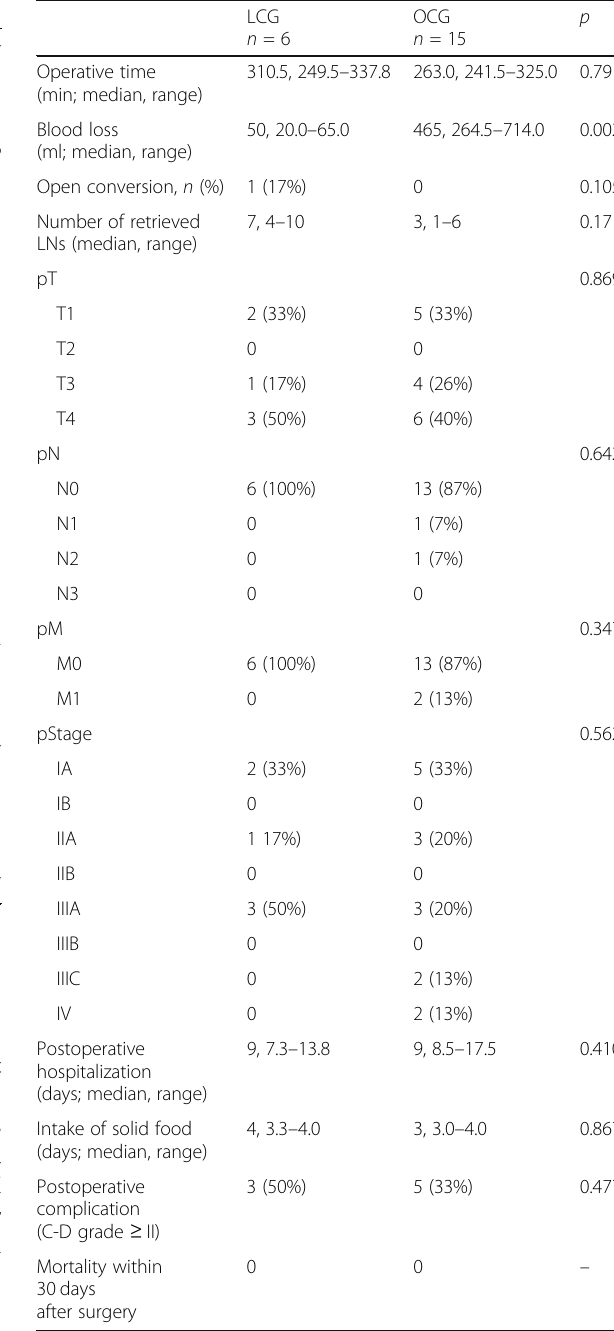
Table 2 Preoperative patient characteristics Table 3 Pathological findings, surgical outcomes, and postoperative